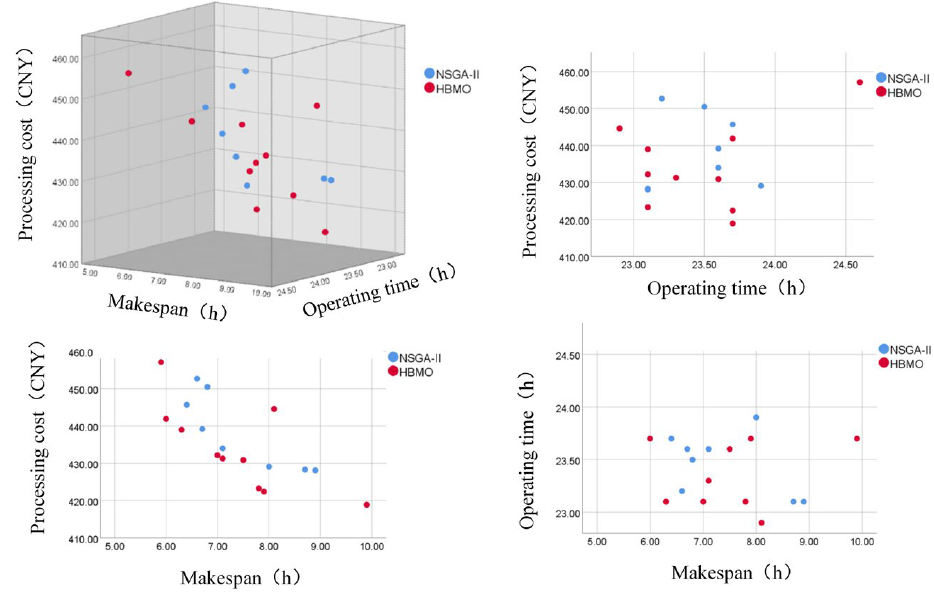
Figure 14. Comparison of Pareto frontier points between HBMO and NSGA-II algorithms. Table 7. Comparison of Pareto solutions between improved HBMO algorithm and NSGA-II algo- rithm.